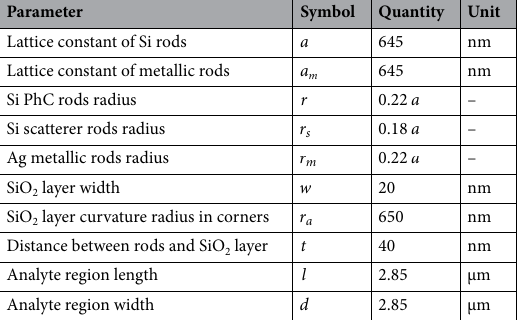
Table 1. Structural parameters of the proposed hybrid P-PhC RI sensor